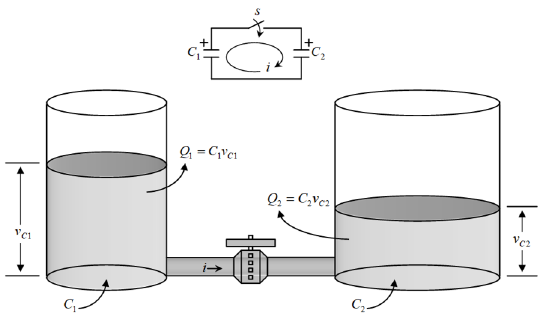
Figure 20. Pure switched-capacitors circuit and their hydraulic analogy.